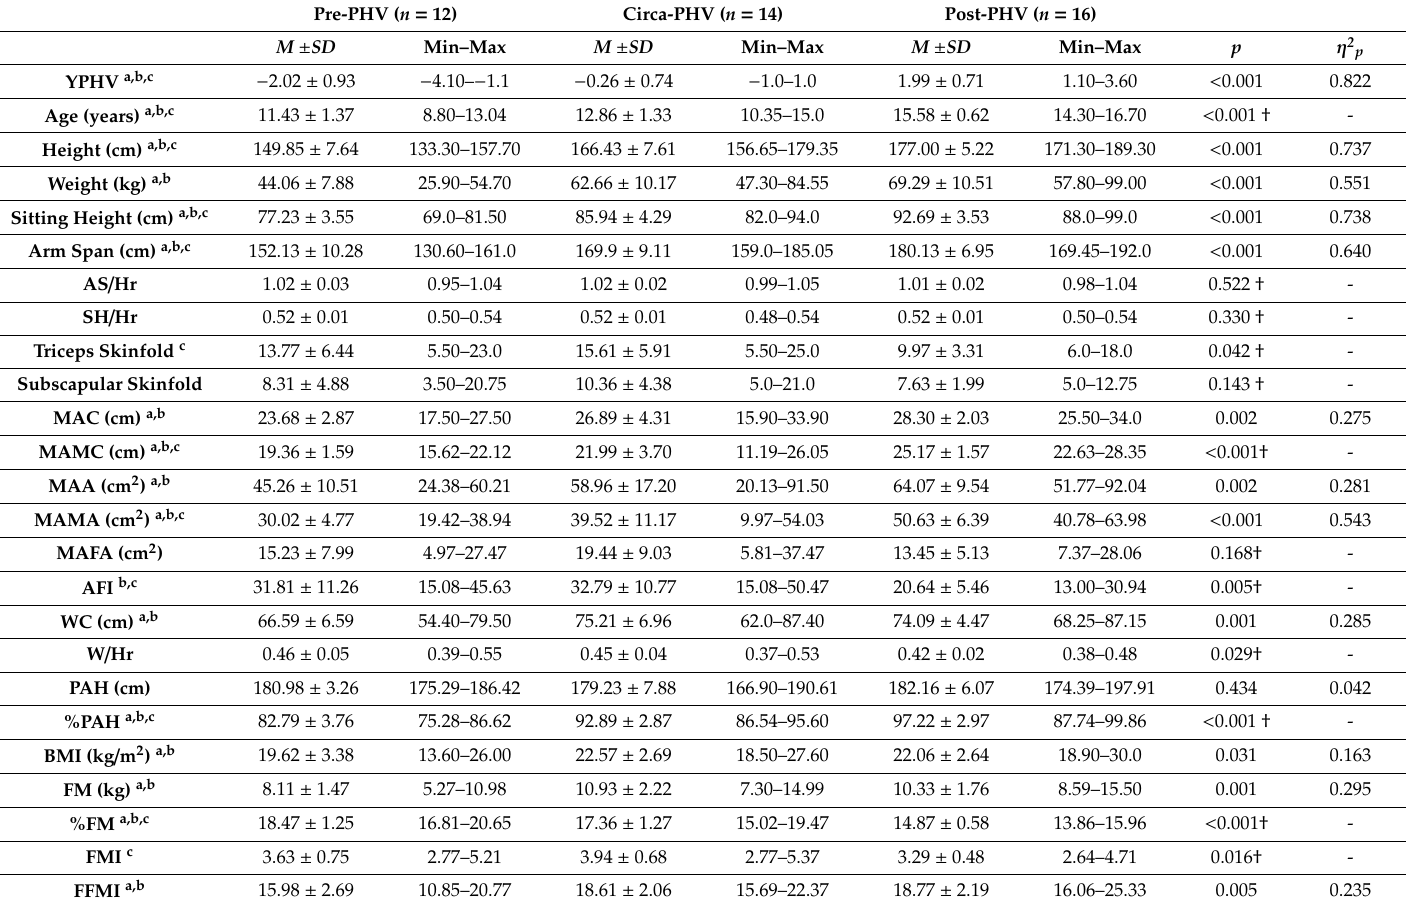
Table 1. Descriptive data of goalkeepers based on maturity